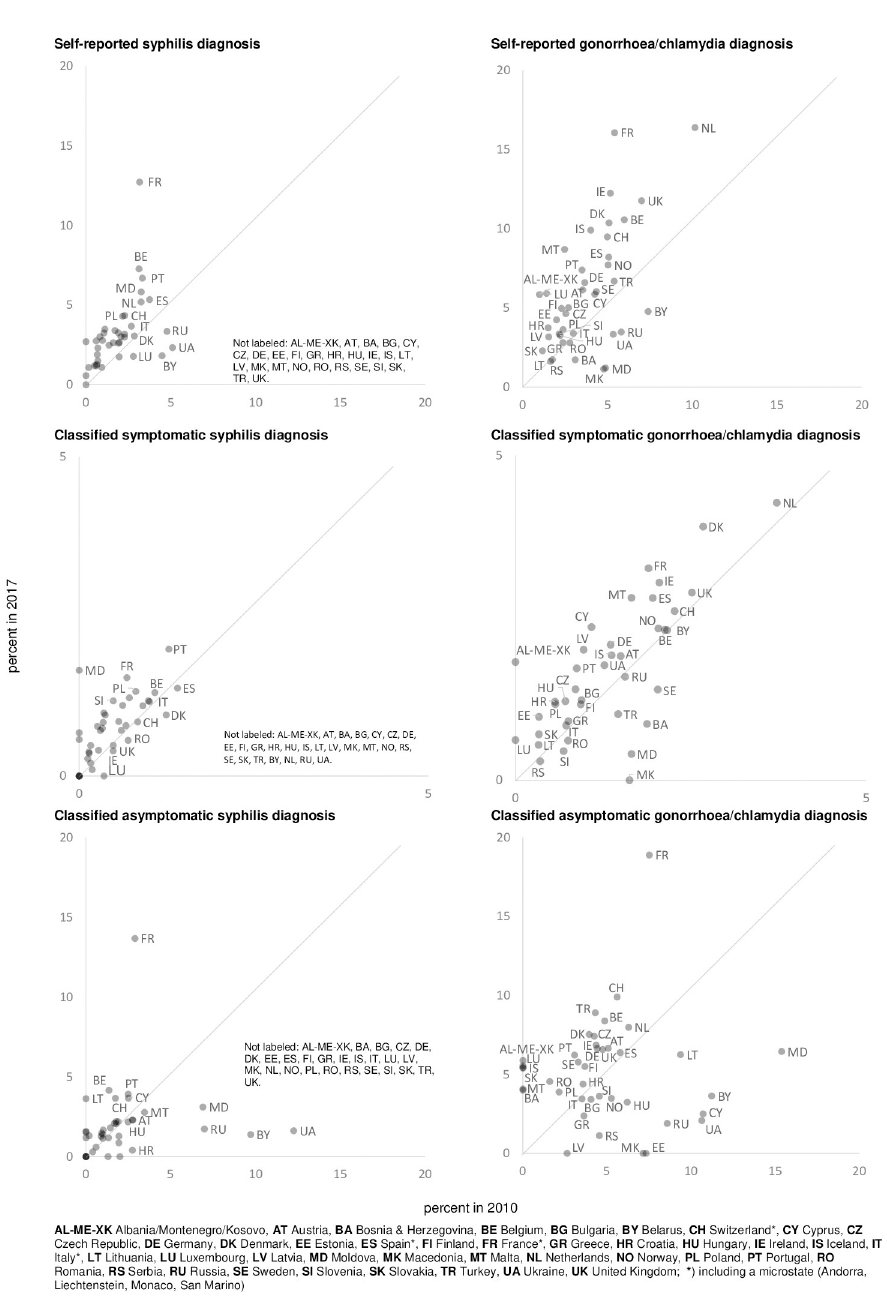
Fig 1. Main outcome variables. Panel of 6 country-level scatter plots: Syphilis diagnosis; Gonorrhoea/Chlamydia diagnosis; Classified symptomatic syphilis diagnosis; Classified symptomatic gonorrhoea/chlamydia diagnosis; Classified asymptomatic syphilis diagnosis; Classified asymptomatic gonorrhoea/chlamydia diagnosis. participants screened with a urine-based STI test or genital swab and an anal swab in the previ- ous twelve months. As the figure demonstrates, in almost all countries the proportions of men screened with a blood-based STI test and the combination of a urine-based test or genital swab and an anal swab have increased to different extents.